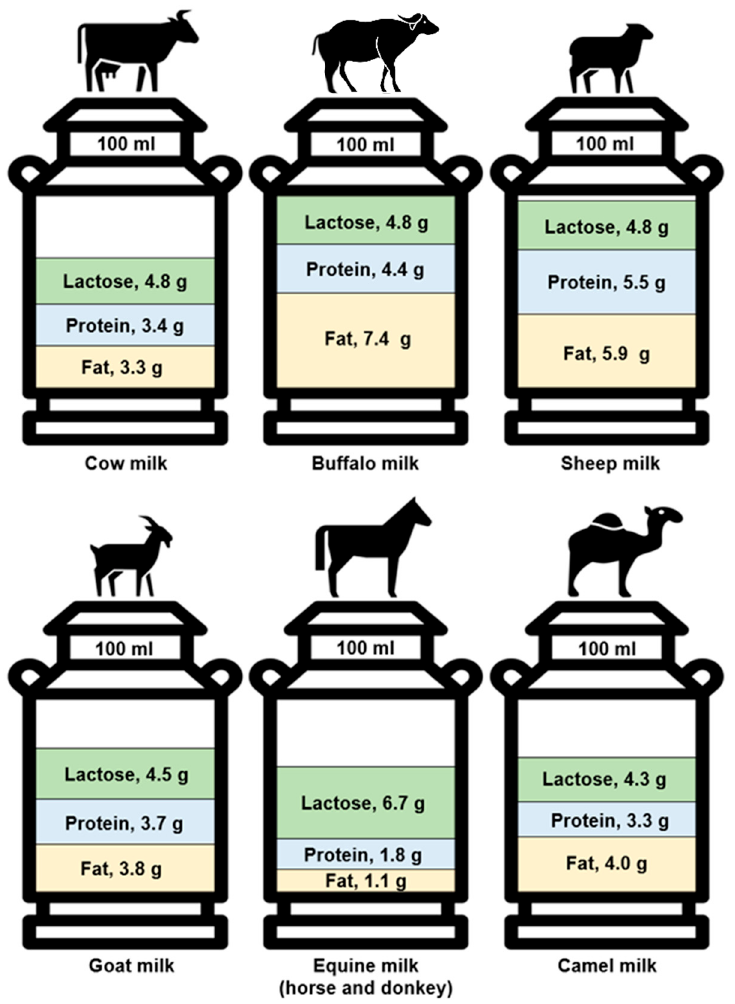
Figure 1. The composition of different species’ milk by fat, protein, and lactose content per 100 mL [22,29,34,35]. Equine milk values represent the mean nutrient content in mare and donkey milks.